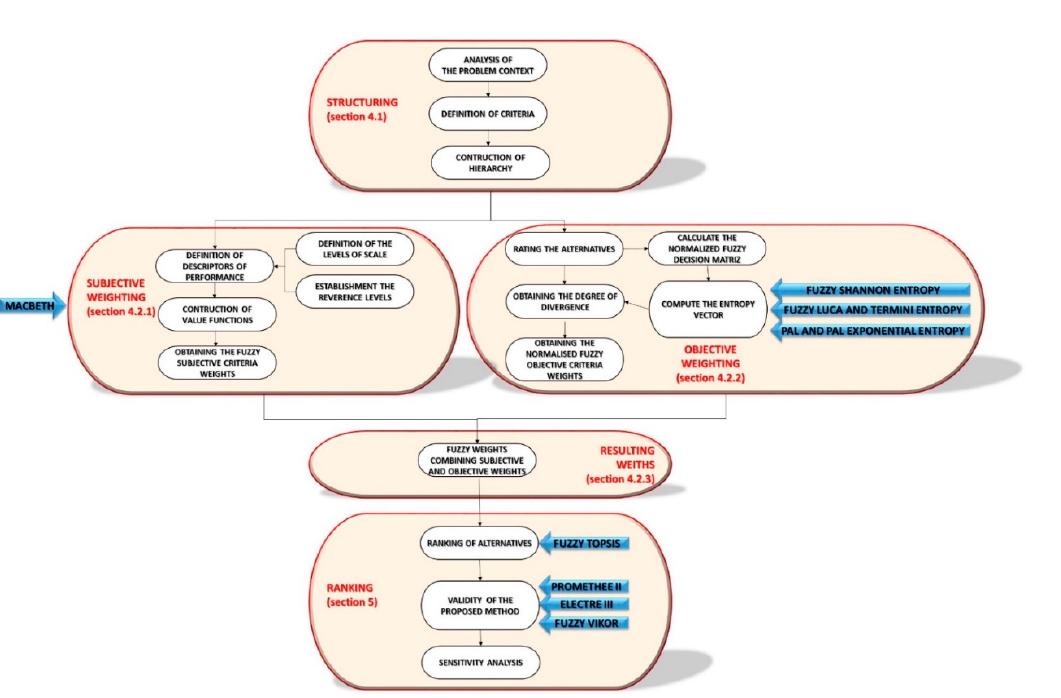
Figure 2. Flow diagram of the